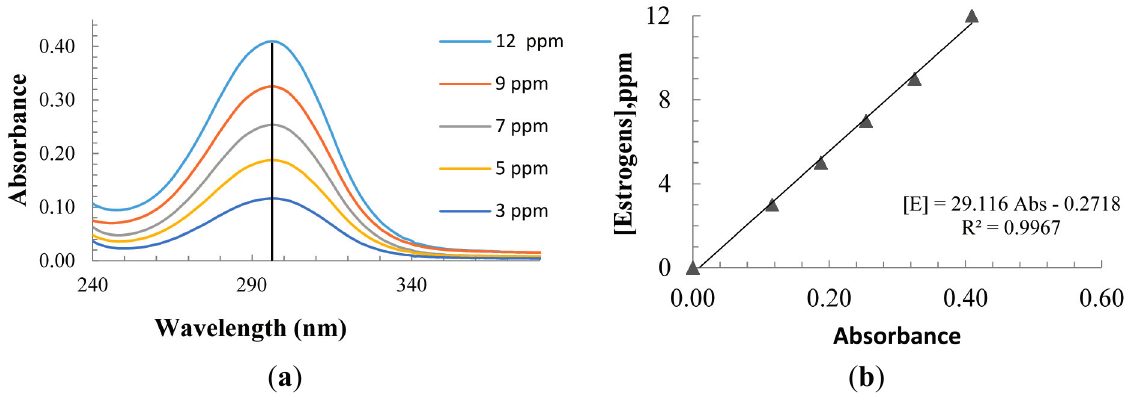
Figure 11. ( a ) UV absorbance of estrogens at different concentrations, showing a peak absorption wavelength at 297 nm. ( b ) Calibration curve for estrogens in tap